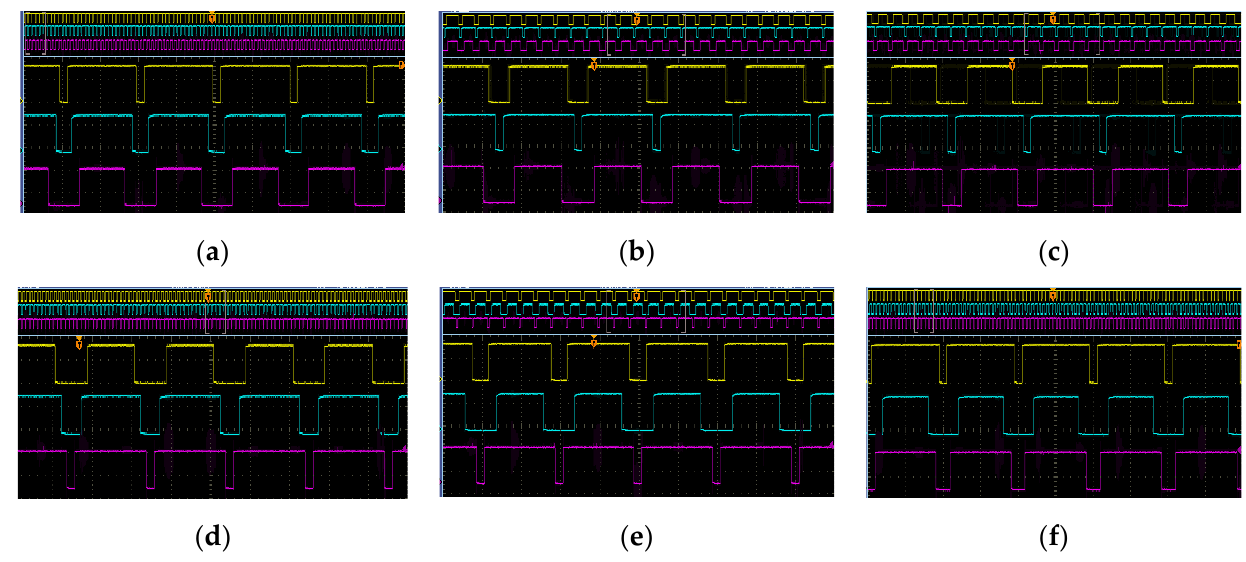
Figure 17. Schematic diagram of PWM waves in different sectors. ( a ) SVPWM first sector; ( b ) SVPWM second sector; ( c ) SVPWM third sector; ( d ) SVPWM fourth sector; ( e ) SVPWM fifth sector; and ( f ) SVPWM sixth sector.